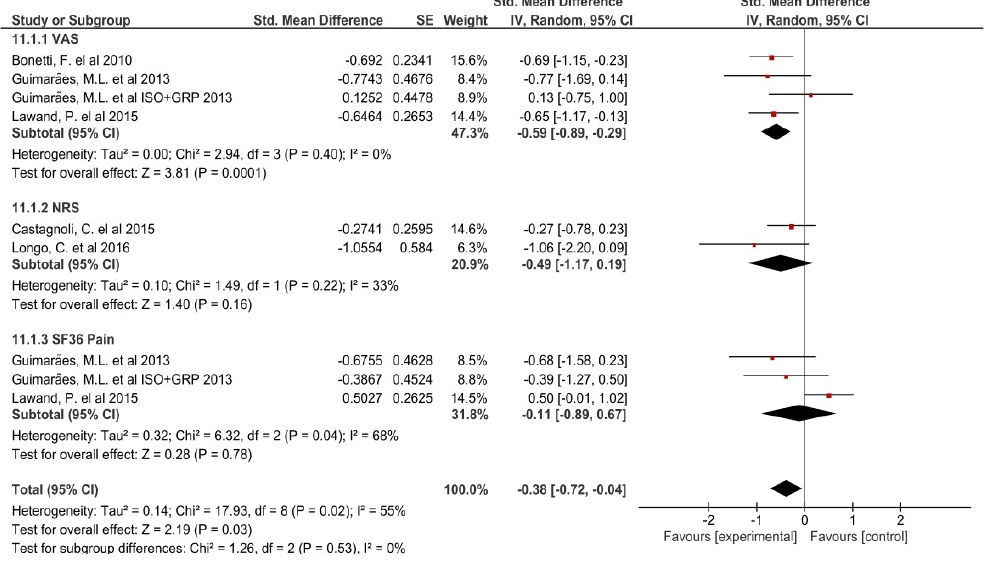
Figure 3. Effects by subgroups of GPR on pain.